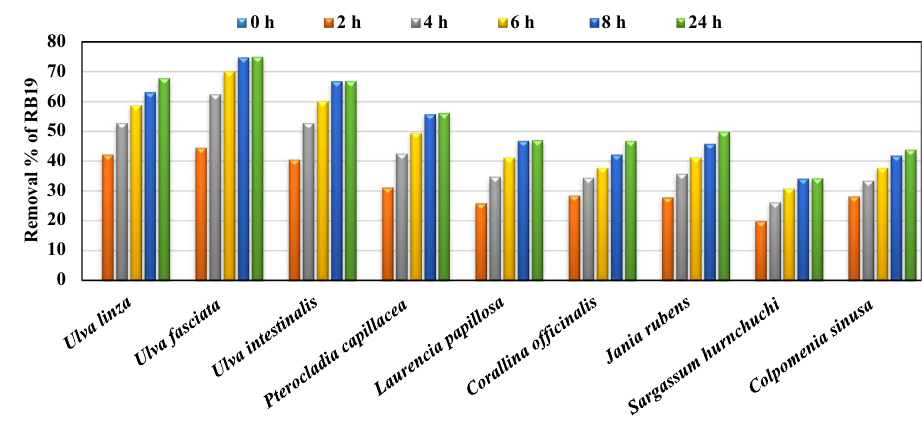
Fig. 5 Removal percentage of Reactive Blue 19 by the nine studied dried algal species